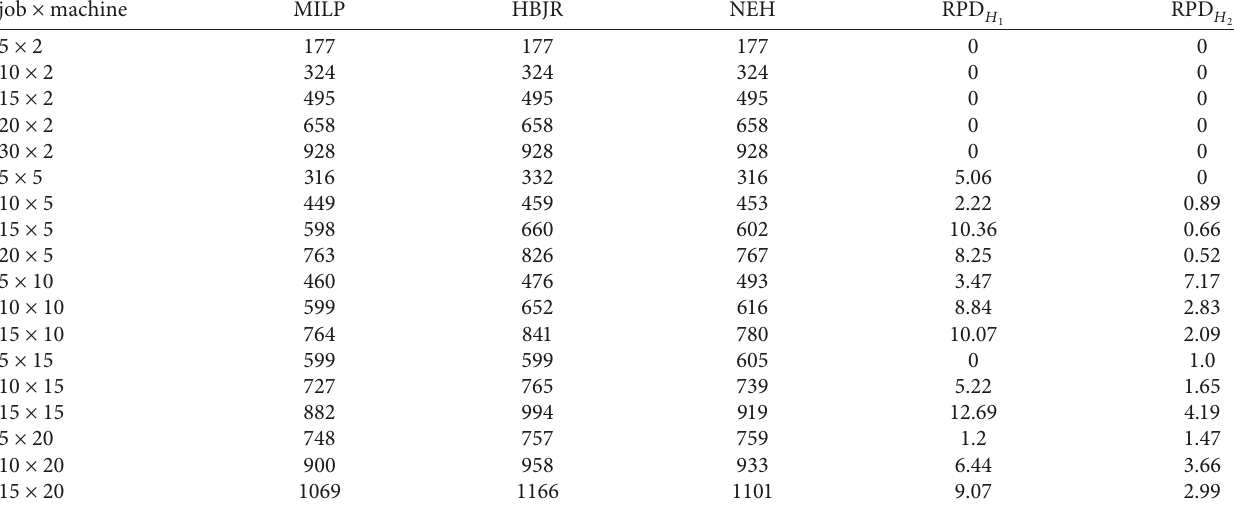
Table 2: Comparison between mixed-integer linear programming and